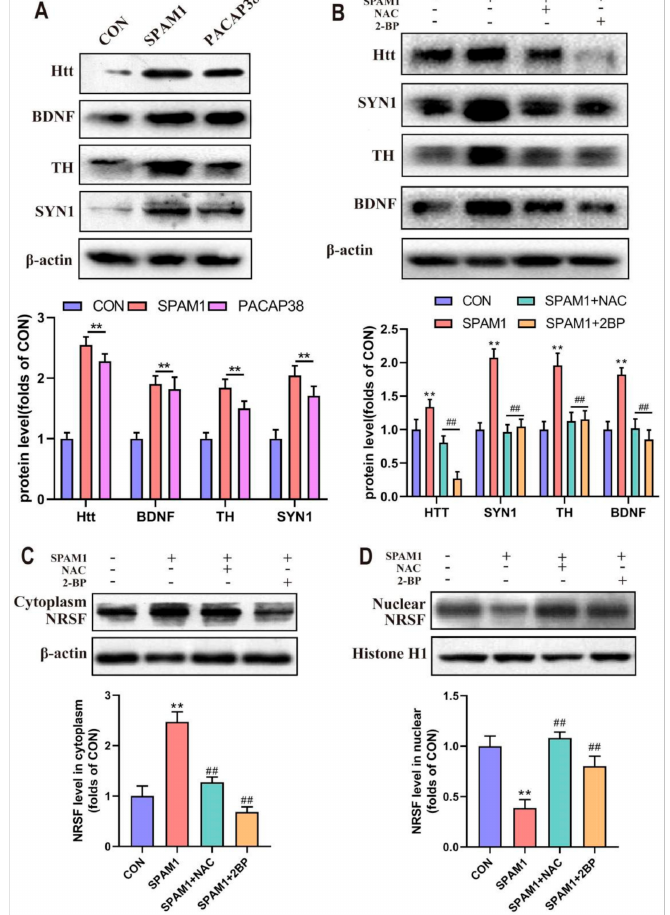
Figure 10. Neuroprotective effect of SPAM1 are associated with the nuclear translocation of PAC1-R. ( A ) The Western blot results ( upper ) and the subsequent quantitative analysis ( down ) showed that both SPAM1 and PACAP38 significantly up-regulated the expression of Htt and the proteins whose gene transcriptions are involved with NRSF, such as BDNF, TH, and SYN1. ( B ) The Western blot results ( upper ) and the subsequent quantitative analysis ( down ) showed that the Htt, BDNF, TH, and SYN1 expression level increased by SPAM1 treatment was significantly inhibited by NAC and 2-BP; ( C , D ) the retention of NRSF in cytoplasm and decrease in NRSF in nuclear induced by SPAM1 were both significantly inhibited by 2-BP and NAC. **, p < 0.01, vs. CON; ##, p < 0.01, vs. SPAM1. Data are presented as the mean ± SEM of three